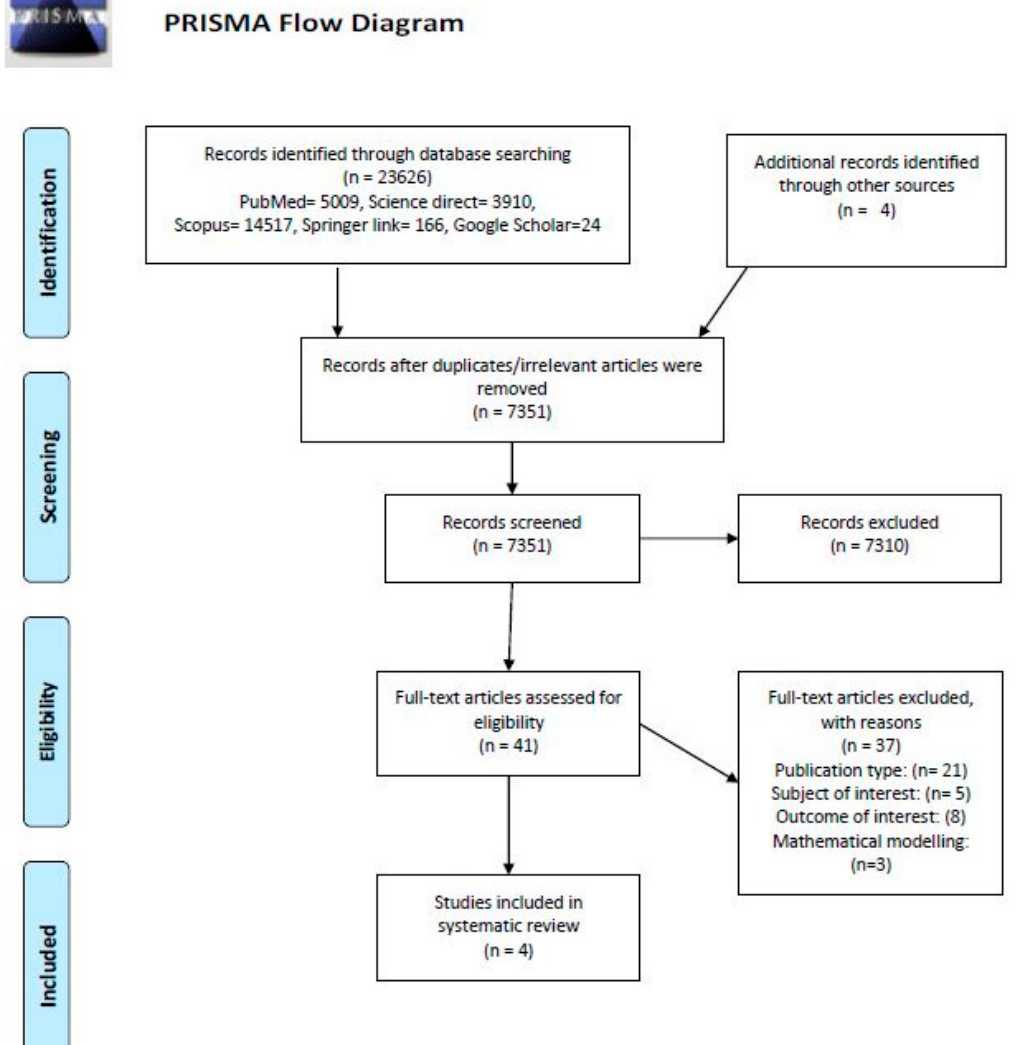
Figure 1. Preferred Reporting Items for Systematic Reviews and Meta-Analyses (PRISMA) flow diagram for the screening and selection of studies.